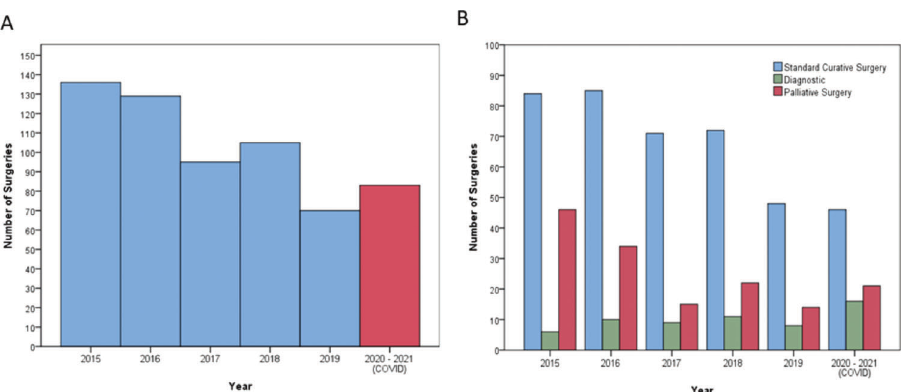
Figure 1 - (A) Total surgical procedures performed between 2005 and 2021. (B) Intention of treatment: curative surgery, palliative surgery, or diagnostic procedures. Table 1 - Clinicopathological and surgical characteristics of patients with GC according to the groups. Control group COVID group Variables n=535